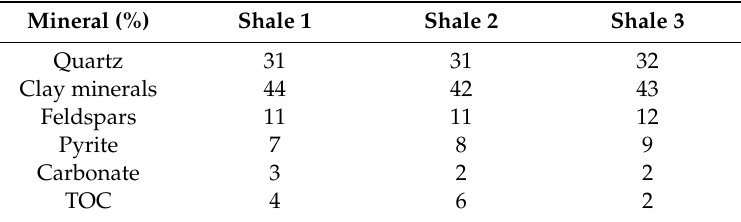
Table 3. Minerology of the three shale samples.